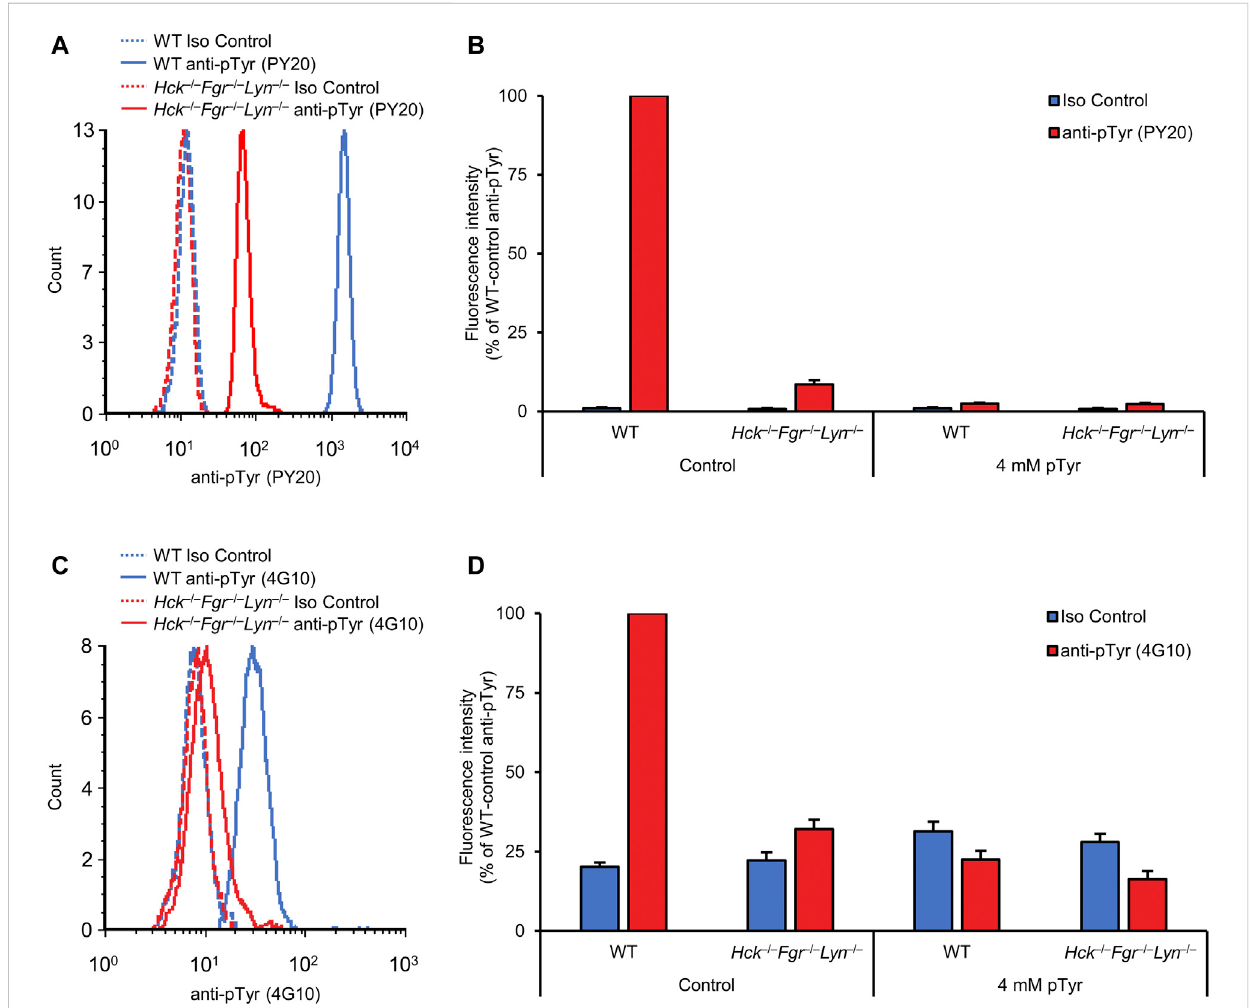
FIGURE 4 Reduced basal tyrosine phosphorylation in Hck − / − Fgr − / − Lyn − / − neutrophils. Blood samples were obtained from untreated wild-type (WT) or Hck − / − Fgr − / − Lyn − / − miceandstainedwiththePY20 (A,B) orthe4G10 (C,D) anti-phosphotyrosineantibodiesalongwithisotypecontrols.Whereindicated, the anti-phosphotyrosine antibodies were presaturated with 4 mM soluble phosphotyrosine. Representative fl ow cytometric histograms (A, C) or geometric mean fl uorescence intensity values normalized to those of WT samples stained with anti-phosphotyrosine antibodies without any presaturationwiththeirantigens (B,D) areshown.BargraphsshowmeanandSEMfrom13to14 (B) and10 – 15 (D) micepergenotypefrom7 (B) and6 (C) independent experiments. pTyr, phosphotyrosine; Iso,